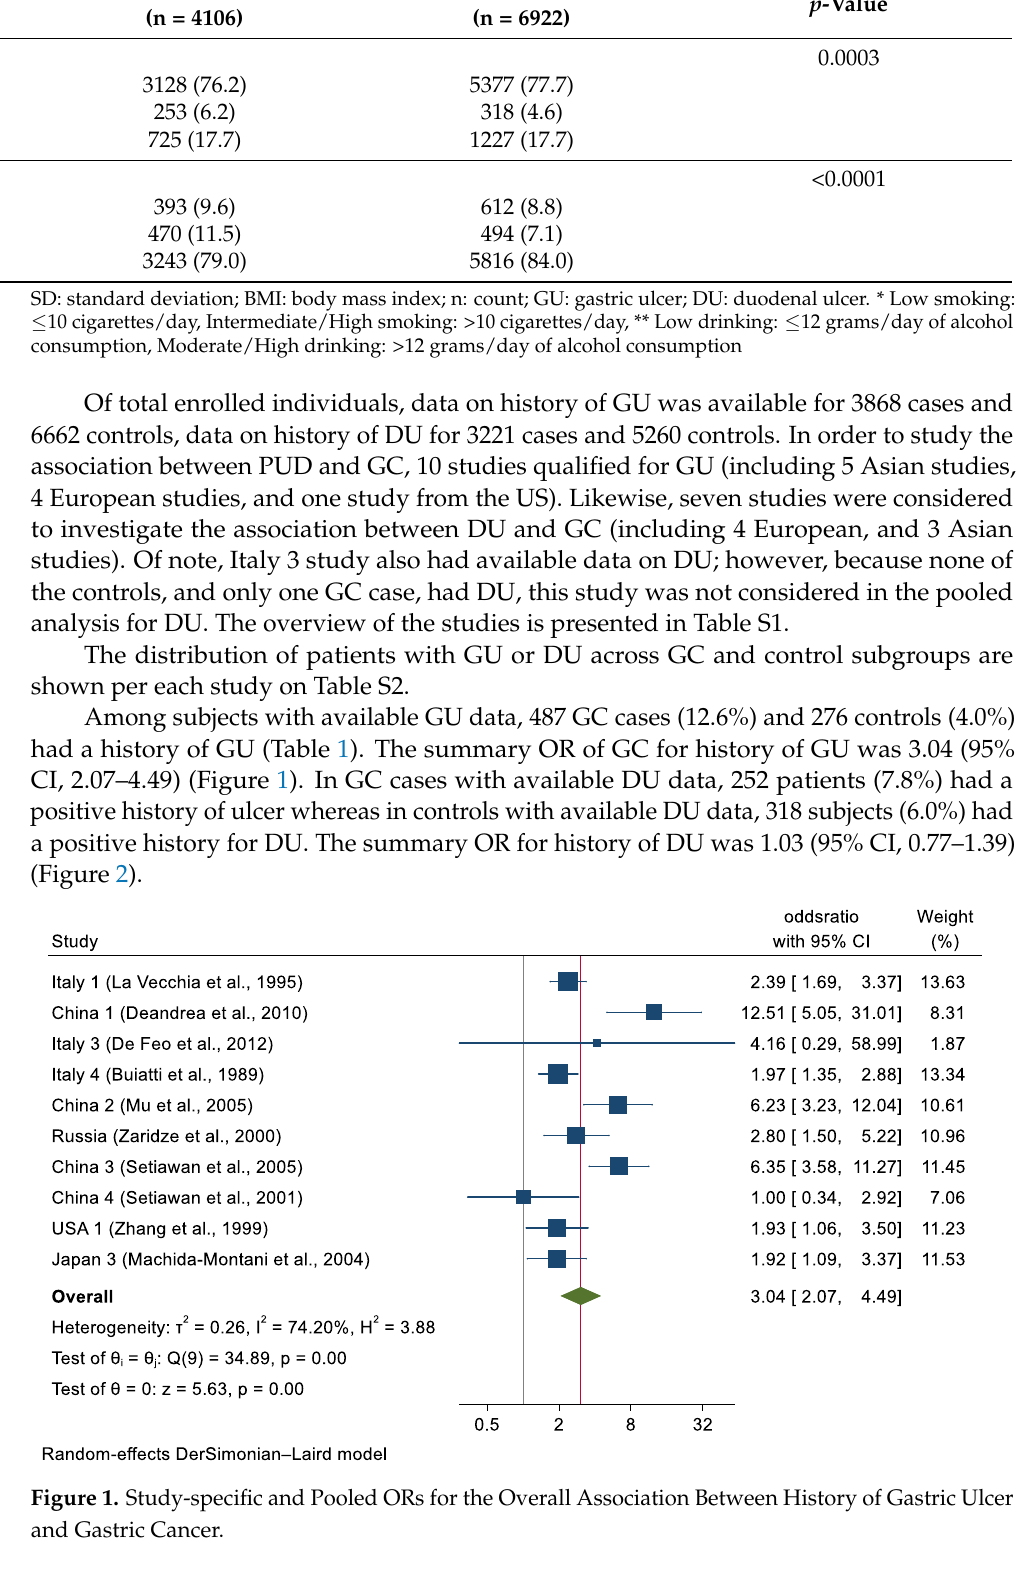
288 Figure 2. Study-specific and Pooled ORs for the Overall Association Between History of duodenal 289 Ulcer and Gastric Cancer.